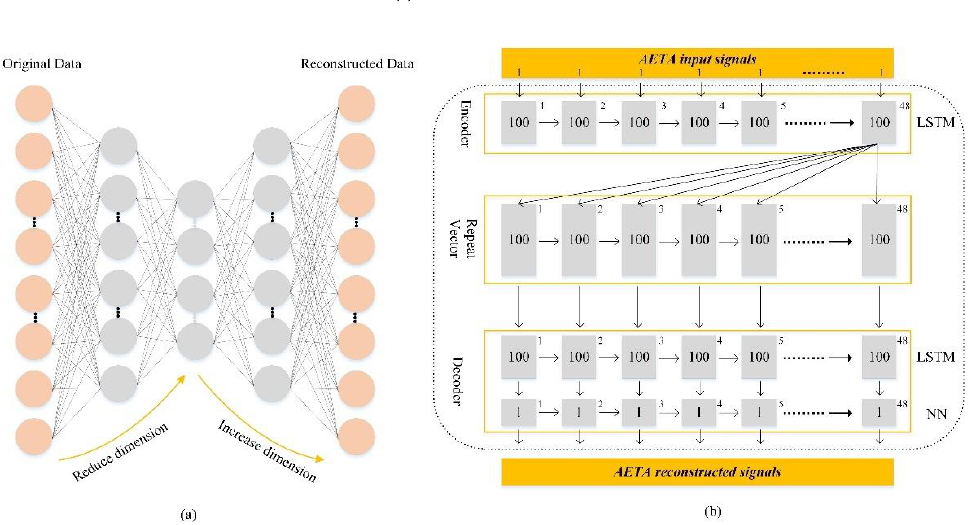
Figure 5. The structure of the autoencoder and LSTM autoencoder. ( a ) Autoencoder model; ( b ) LSTM autoencoder model.